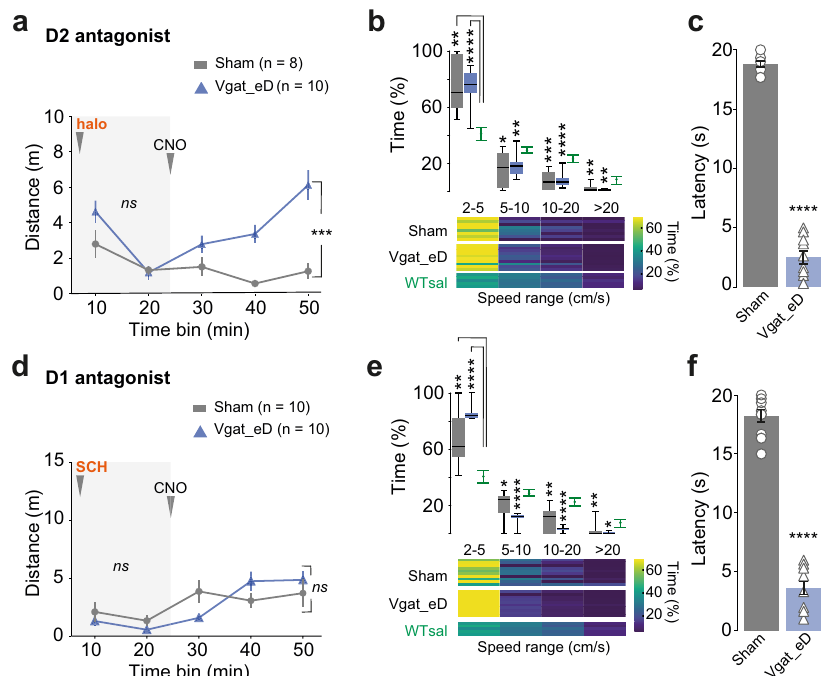
Fig. 9 Bilateral chemogenetic activation of GABAergic PPN neurons alleviates akinesia induced by D2 but not D1-receptor antagonism. a Timeline effect of haloperidol ( “ halo ” ), before (light-gray background) and after injection of CNO in Sham and Vgat_eD mice (mean± SEM). Stats report at the end of the legend. b Upper panel, speed range in Sham (gray) and Vgat_eD (blue) mice after CNO treatment in comparison to WT saline group (green) with min-to-max boxplots. Lower panel shows a heat map with individual mice in horizontal lines and color code for the percentage of time in each speed range. c Average motor initiation latency observed in the Bar test (20 s limit) for Vgat_eD and Sham mice treated with haloperidol and then CNO (symbols represent the average of each mouse, group mean ± SEM). d Timeline effect of SCH23390 ( “ SCH ” ), before and after injection of CNO in Sham and Vgat_eD mice. Graphed as in a . e Upper panel, speed range in Sham (gray) and Vgat_eD (blue) mice after CNO treatment in comparison to WT saline group (green) with min-to-max boxplots. Lower panels show heat maps for the percentage of time in each speed range. Graphed as in b . f Average motor initiation latency obtained in the Bar test for mice treated with SCH and then CNO. Graphed as in c . Data composed of eight Sham halo + CNO ; ten Sham SCH + CNO ; ten Vgat_eD halo + CNO ; ten Vgat_eD SCH + CNO mice. Experimental paradigm as in Fig. 2a. a , d Two-way RM ANOVA with graph report for group effect, analysis is done for each period in separate. b , e Two-way RM ANOVA, Geisser – Greenhouse correction, the report shows Dunnett multiple comparison vs WT sal + sal group. WT is the same as in Figs. 2, 3. c , f Individual values represent the average of three sequential trials/mouse. Two-tailed, non-matched, Mann – Whitney test. See also Fig. S7 and detailed stats in Table S5. Source data are provided as a Source Data fi